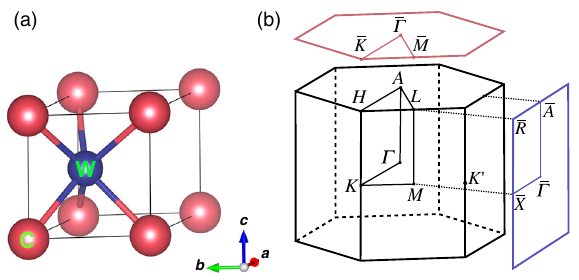
FIG. 3. (a) Primitive unit cell of WC-type structure. (b) The bulk BZ and (001) and (010)